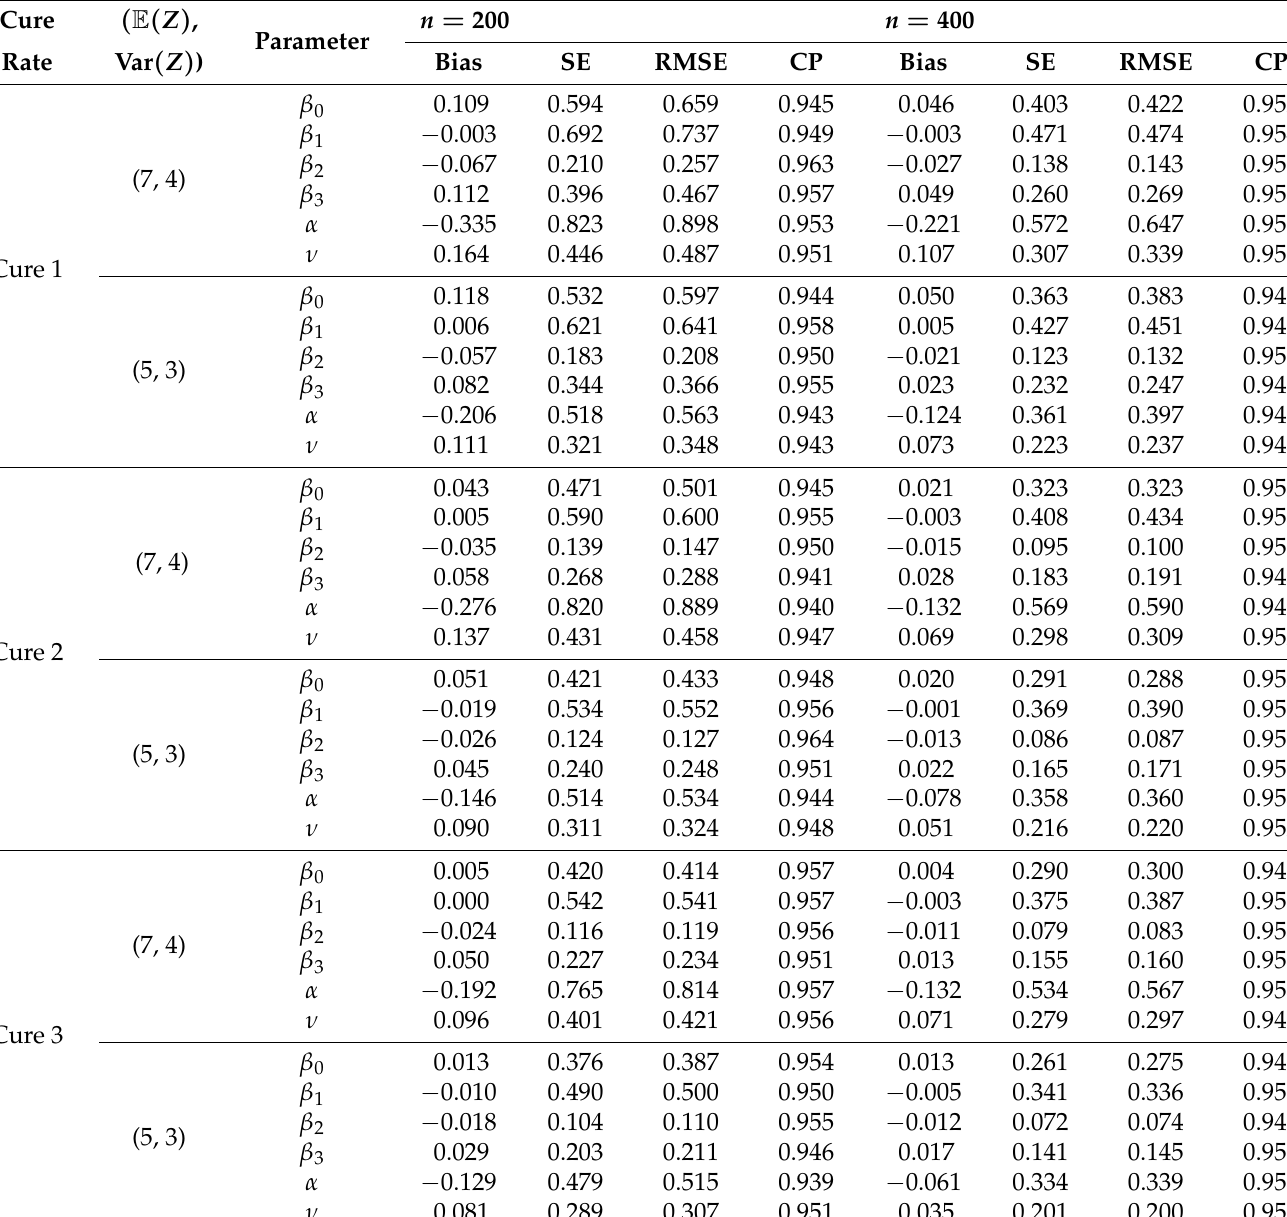
Table 3. Simulated bias (Bias), average of the asymptotic standard errors (SE), root of the simulated mean squared error (RMSE) and coverage probability of the 95% asymptotic confidence intervals (CP) for the Bellcr model.